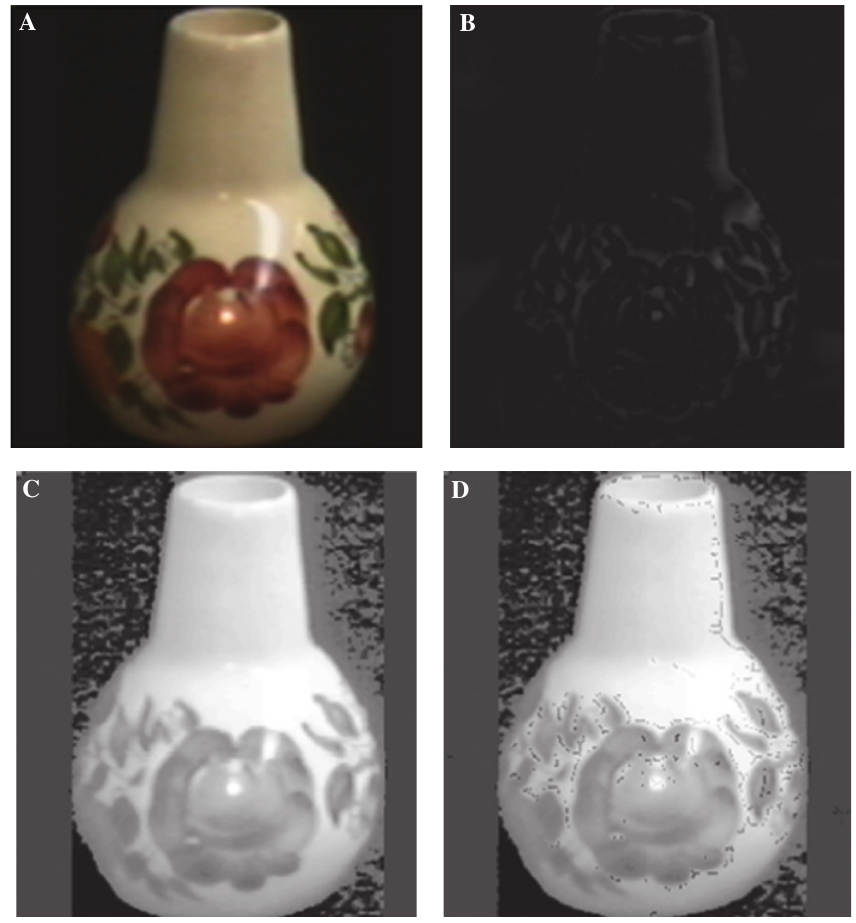
Figure 2: Edge Detection Process. (A) Initial image. (B) Image after histogram equalization and median filtering. (C) Edge detected by BEMD. (D) Image after replac- ing edge value of (B) by edge value of